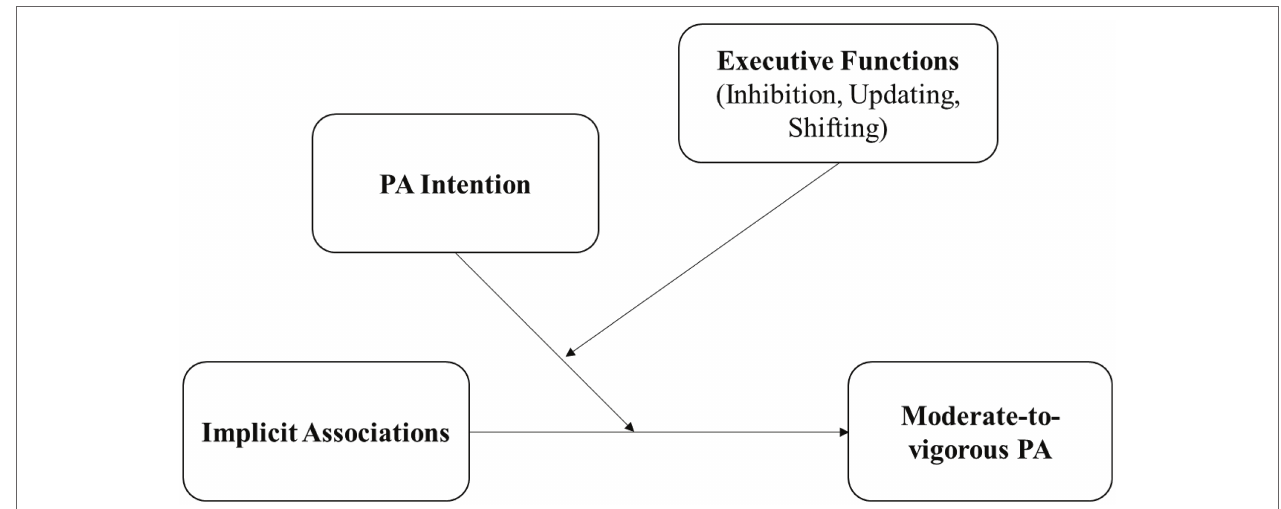
FIGURE 1 | Conceptual research model based on dual-process theories. PA = physical